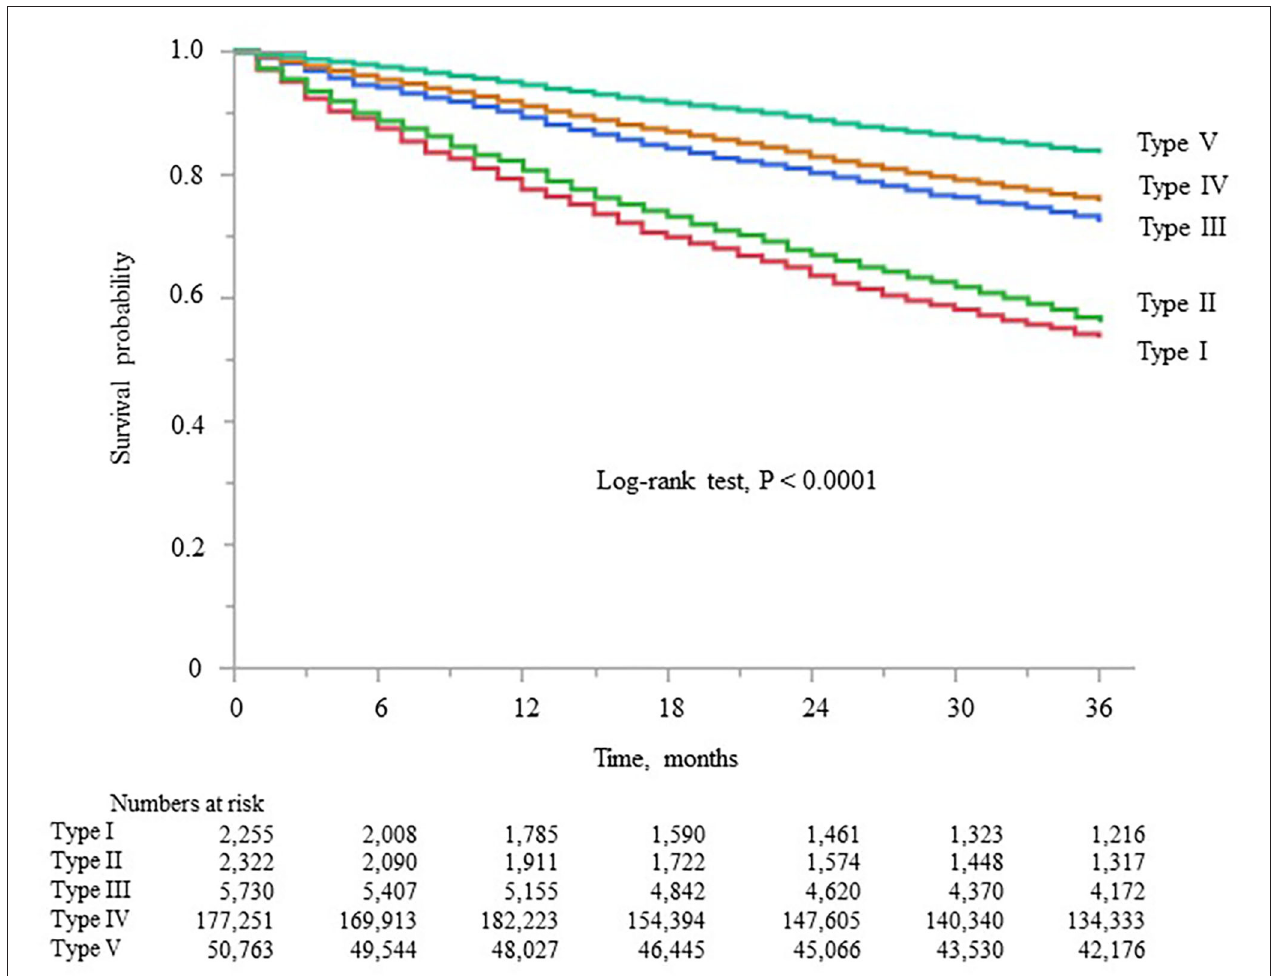
FIGURE 4 | Kaplan–Meier survival curve for all-cause mortality in the five dialyzer type groups in the Japanese